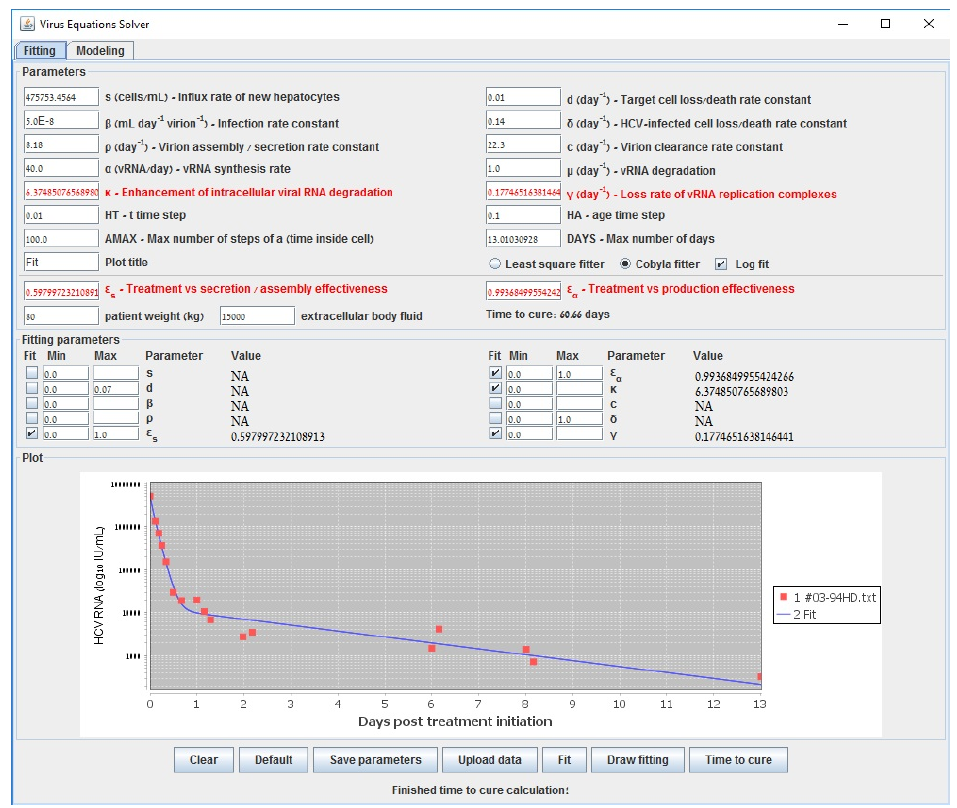
Figure 4. End fit using COBLYA that emanates from data of a patient reported in [48].